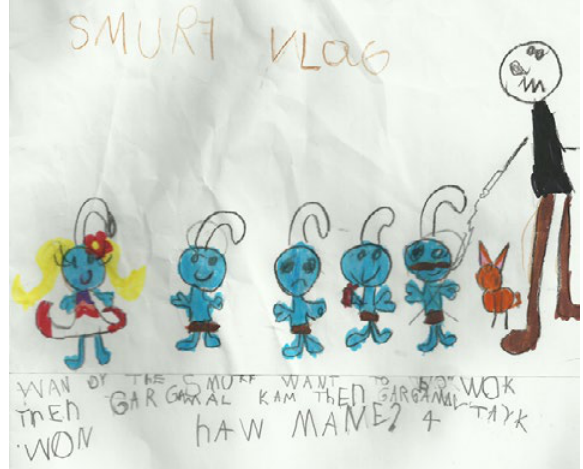
Figure 4: Math story of a five-year-old: “One of the smurf want to go work then Gargamel came the Gargamel took one. How many?